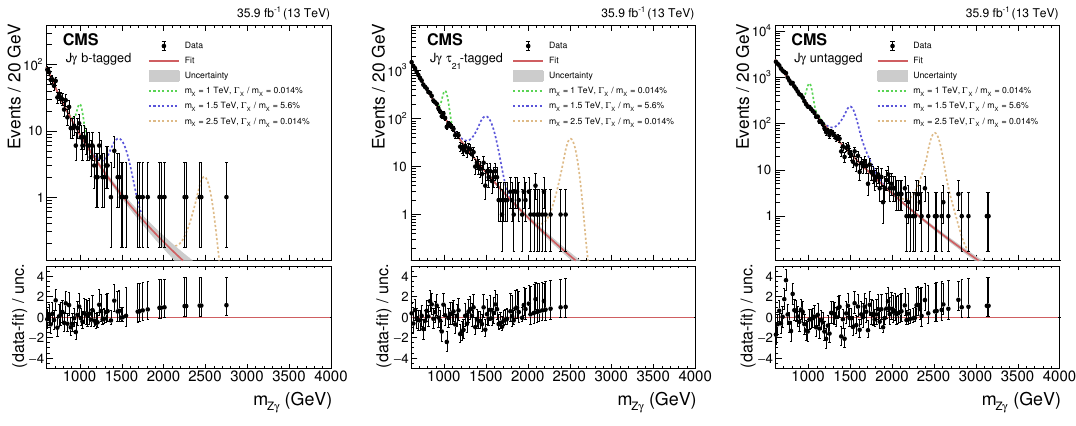
Figure 2 . Observed m Z (cid:13) invariant mass spectra in the J (cid:13) channel in the b-tagged (left), (cid:28) 21 - tagged (center), and untagged (right) categories. The best (cid:12)ts to the background-only hypotheses are represented by the red lines, with their 68% CL uncertainty bands given by the gray shadings. Several narrow and broad signal benchmarks with arbitrary normalization are shown on top of the background prediction with the dashed lines. The lower panels show the di(cid:11)erence between the data and the (cid:12)ts, divided by the uncertainty, which includes the statistical uncertainties in the data and the (cid:12)t. For bins with a small number of entries, the error bars correspond to the Garwood con(cid:12)dence intervals